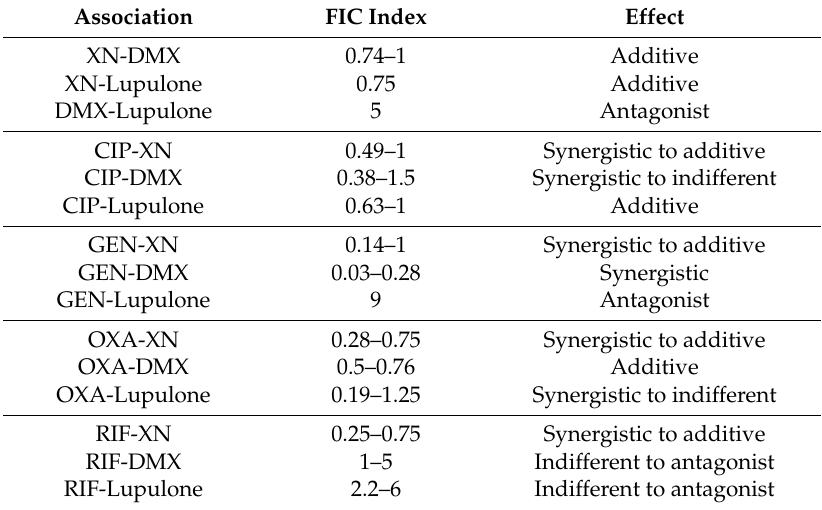
Table 4. Effect of the combination of hops compounds between them and with selected